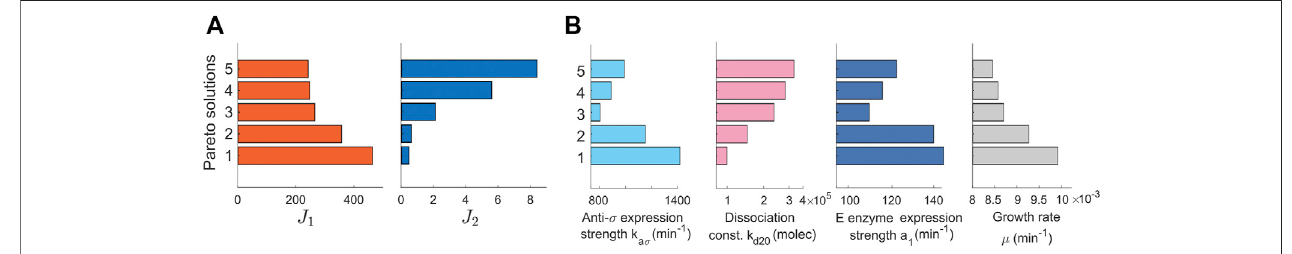
FIGURE2| Paretosolutions.ParetofrontandParetosetofselectedsolutions. (A) Paretofrontshowingthesolutionsofthemultiobjetiveproblem.Thevaluesofthe objectives J 1 and J 2 ( x -axis) are represented for different solutions ( y -axis). (B) The Pareto set represented with a plot for each tuned parameter. The tuned values of the parameters ( x -axis) are shown for each selected Pareto solution ( y -axis). The set of solutions constitutes the library of biocontrollers and biosensors obtained with the multiobjective optimization tuning